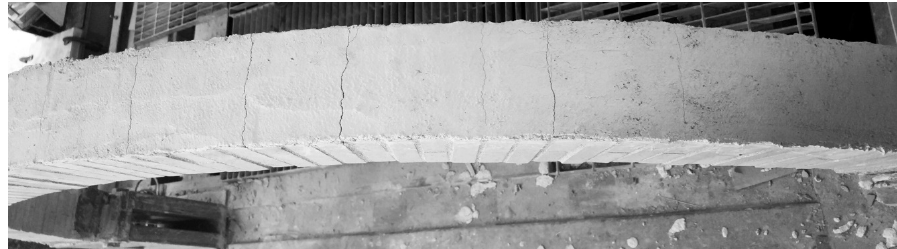
Figure 5. Superficial cracks on lime matrix, where hinge 2 formed on the un-strengthened arch.